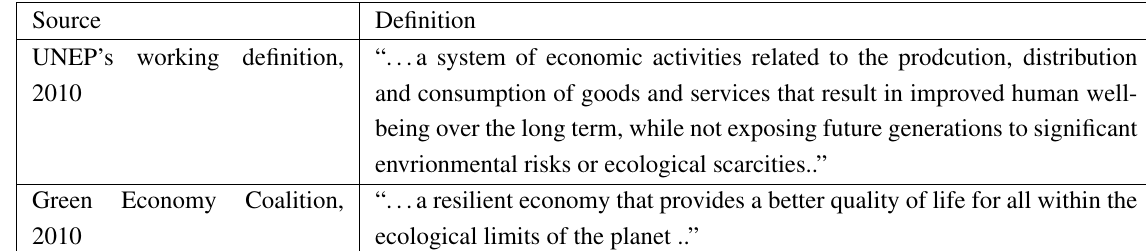
Table 1. Some Green Economy